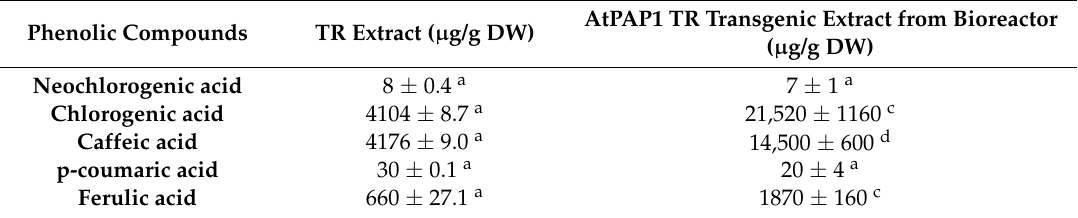
Table 1. Phenolic acids content in TR and AtPAP1 TR roots of L. sibircus. Data from our previous studies [15,17].